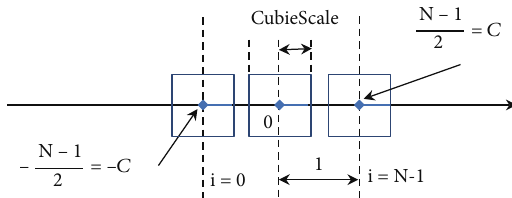
Figure 2: Arrangement of cubies in the cube coordinate